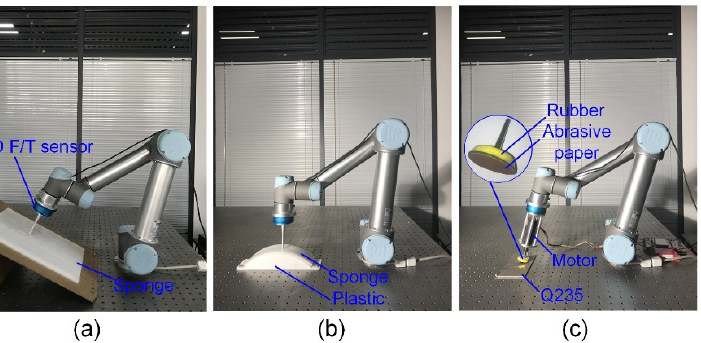
Figure 7. Schematic of the experimental platform.